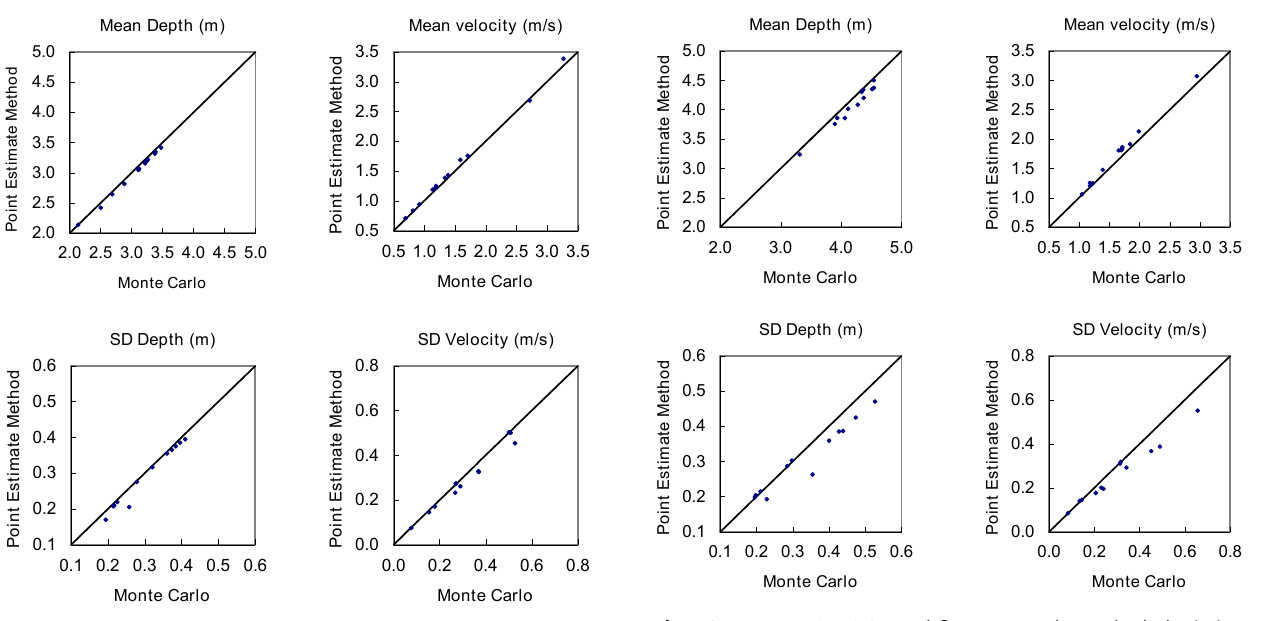
Fig. 8. 1-D HEC-RAS model. Mean and standard deviations of wa- ter depth and velocity predicted by point-estimate method against Monte Carlo. Results for n i uniformly distributed and flow case 200m 3 s − 1 . Each dot corresponds to a different RS of the model.